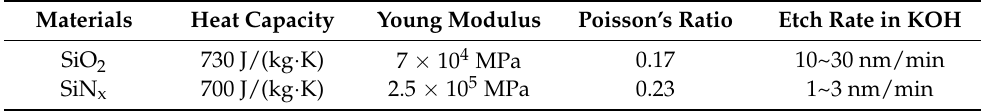
Table 2. Physical properties of SiO 2 and SiN x .